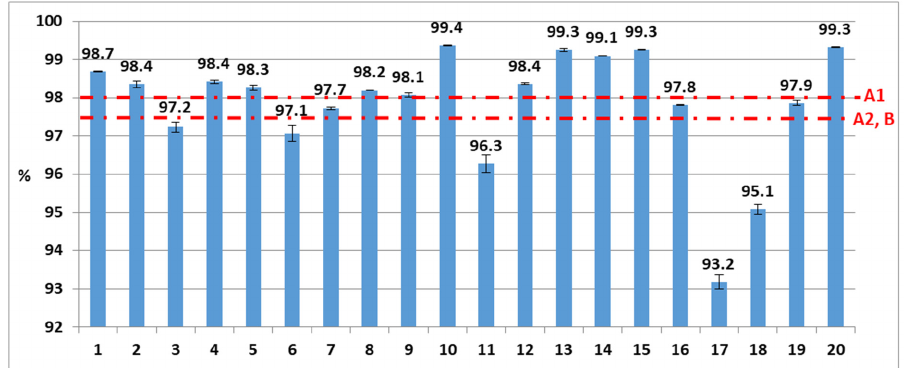
Figure 6. Normal P-P Plot of regression of the standardized residual of ash content (dependent variable).